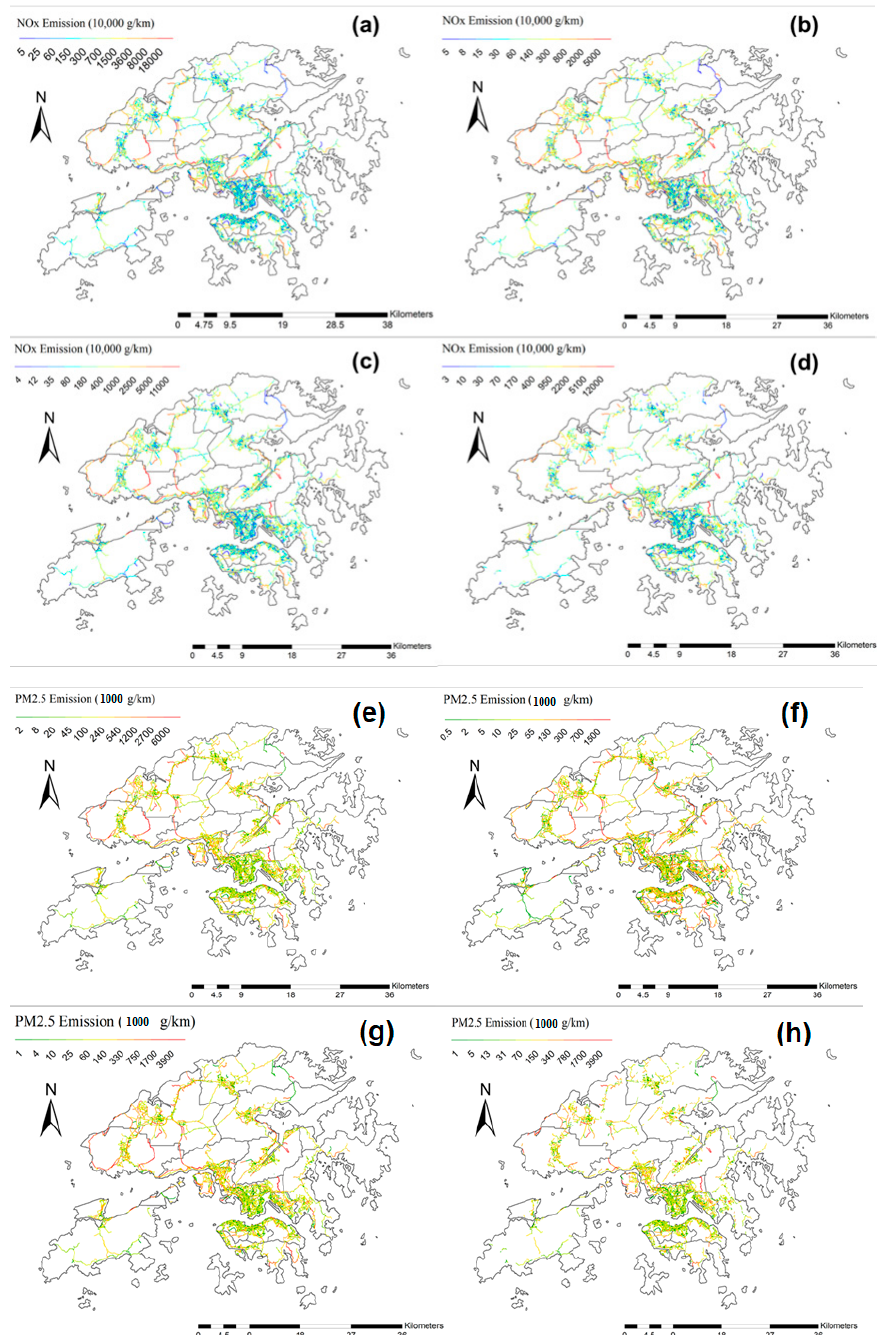
Figure 6. Spatial Distributions of Street-Level NO x (Top Panel: ( a – d )) and PM 2.5 (Bottom Panel: ( e – h )) Traffic Emissions (in 10 4 g/km and 10 3 g/km respectively) retrieved from ( a ) and ( e ) Case Study 1; ( b ) and ( f ) Case Study 2; ( c ) and ( g ) Case Study 3; and ( d ) and ( h ) Case Study 4 within all districts